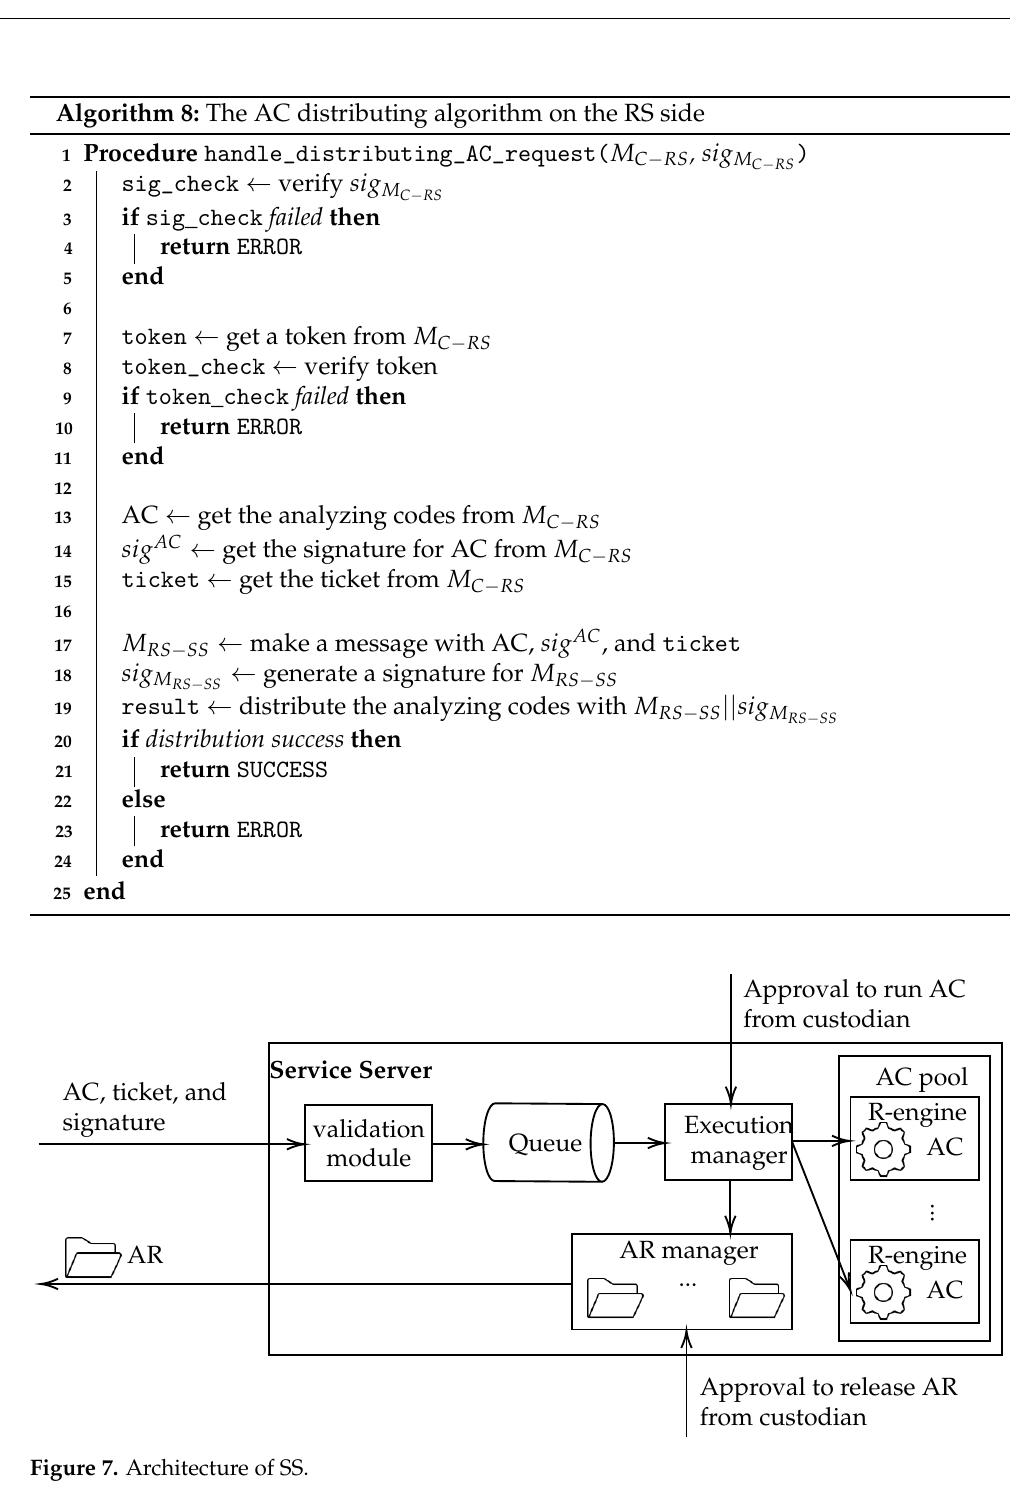
Figure 7. Architecture of